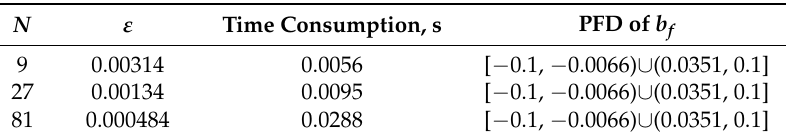
Table 3. Results of Method 2 for different scale